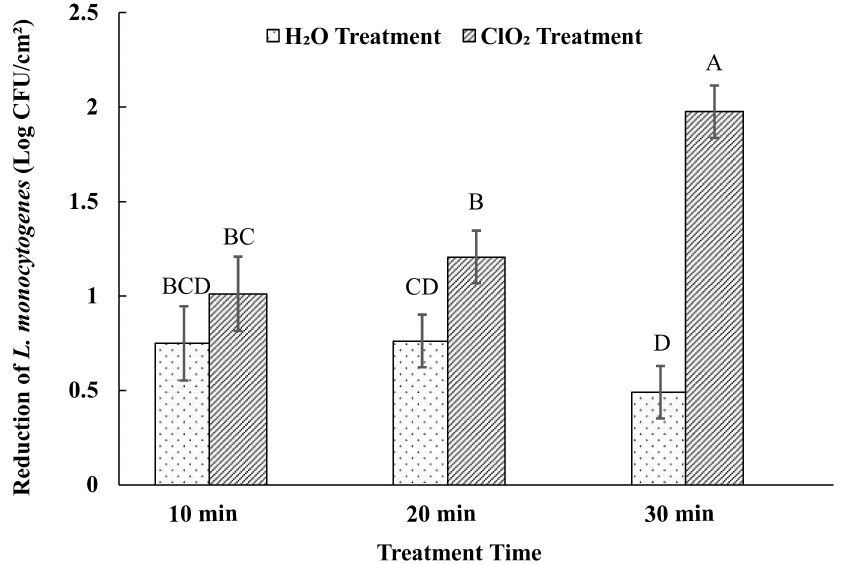
Figure 3. E ff ects of aqueous ClO 2 and water treatment on the reduction of L. monocytogenes. Reduction of L. monocytogenes on sweet potato surfaces after 5 ppm aqueous ClO 2 treatment for 10, 20, and 30 min and water treatment at 22 ± 1 ◦ C. Each bar diagram represents average counts ± standard error. Di ff erent uppercase letters on the top of the diagrams means that the reductions between the treatments and times were significantly di ff erent ( p <